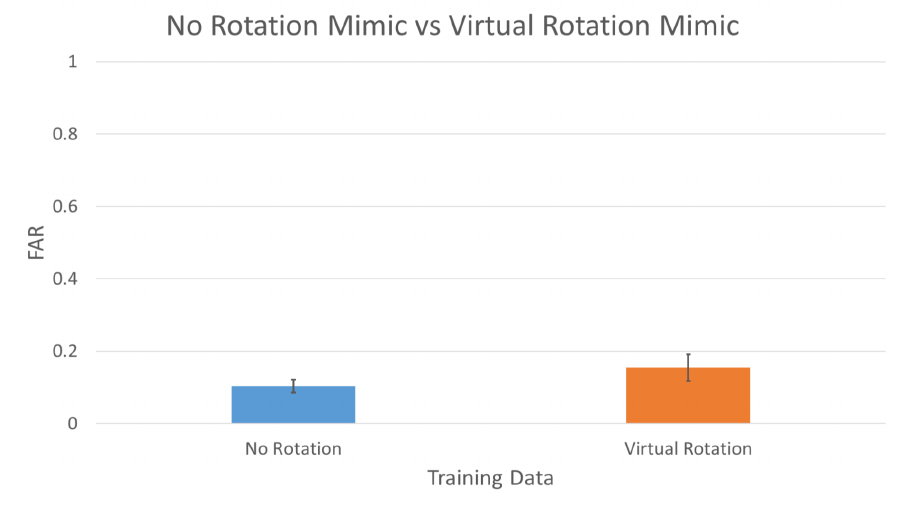
Figure 12. Different training scenarios with different testing scenarios.